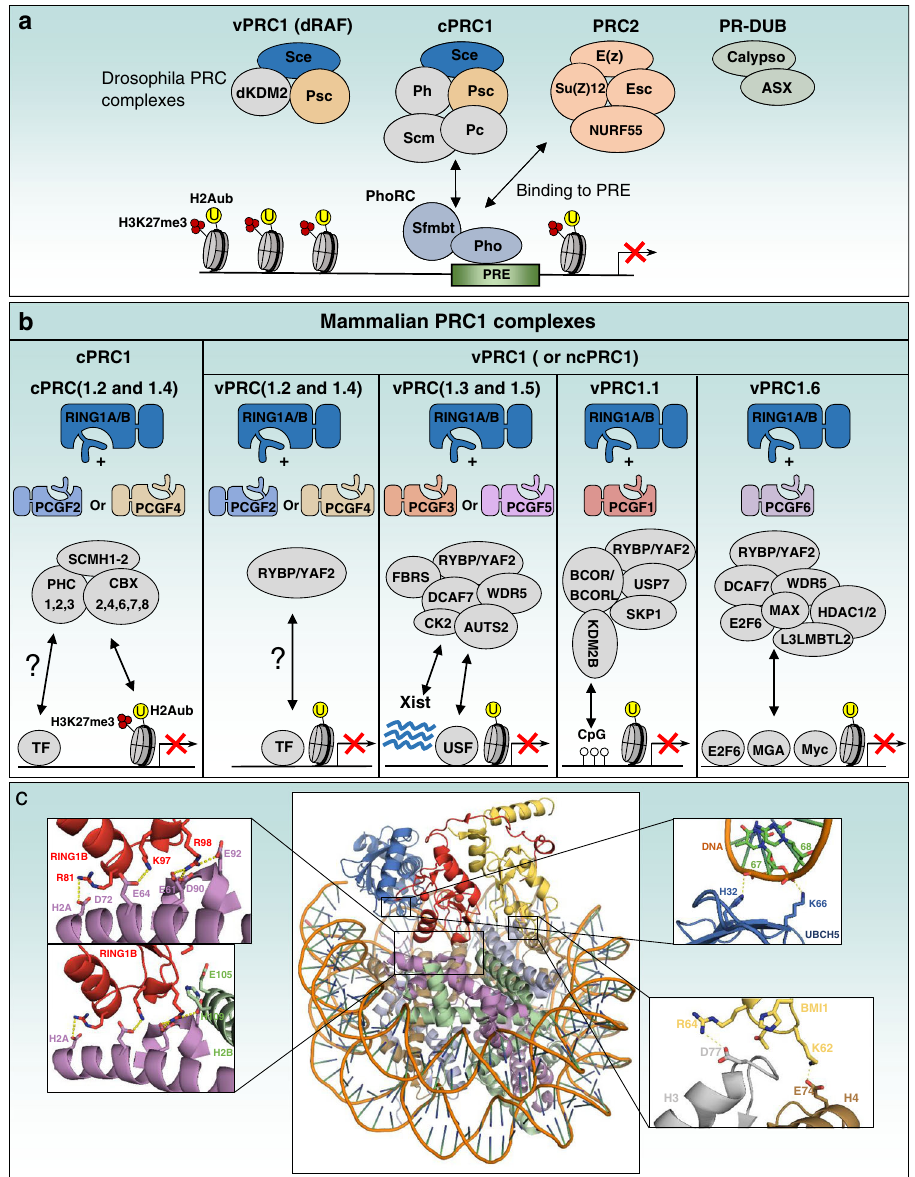
Fig. 2 PcG complexes in Drosophila and PRC1 complexes in mammals. a Schematic representation of the fi ve PcG complexes in Drosophila: canonical (cPRC1) and variant (vPRC1:dRAF) PRC1 complexes, PRC2 complex, PR-DUB complex and PhoRC complex. PhoRC binds to gene regulatory regions via the interaction of its subunit Pho with speci fi c DNA sequences, PRE (PcG Responsive Elements). Pho can also directly bind to components of cPRC1 complexes to mediate their recruitment even in the absence of H3K27me3. The arrows indicate protein interactions responsible for the recruitment of PcG complexes to the PRE. b Schematic representation of the canonical (cPRC1) and variant (vPRC1) PRC1 complexes in mammalians. RING1A or RING1B are obligate components of the PRC1 complexes. Their association with either PCGF2/PCGF4 or other PCGFs (PCGF1, PCGF3, PCGF5, PCGF6) lead to the formation of cPRC1 or variants vPRC1 complexes, respectively. CBXs/HPHs and RYBP/YAF2 associate in mutually exclusive manner with RING1A/RING1B for the formation of cPRC1 and vPRC1 complexes, respectively. H3K27me3 and CpG islands recruit cPRC1 and vPRC1/PCGF1 complexes respectively. Transcription factors (TF), USF and other chromatin factors (E2F6, MGA, MYC) might also be involved in the recruitment of PRC1 to chromatin. The arrows indicate protein-protein or protein DNA/RNA interactions responsible for the recruitment of PRC1 complexes to chromatin. Ubiquitination is shown as the yellow circle and H3K27me3 is shown by the three red circles ( a , b ). c In the center, crystal structure of a minimal human PRC1 complex (RING1B /BMI1-UbcH5c) interacting with the nucleosome core particle (NCP) (PDB: 4R8P). The left panels show the contact between RING1B and H2A/H2B acidic patch. The top right panel shows the DNA-UBCH5 interactions. BMI1 also makes polar contacts with Histone H3 and H4 as shown in the bottom right panel. Interaction of RING1B with BMI1 on one hand and histone H2A on the other hand is essential for establishing H2Aub on the speci fi c DNA sequences called PRE (or PcG Responsive Ele- recruit its subunits directly to DNA, in the absence of ments) 48,49 . PRE-mediated gene silencing was later found to nucleosomes 53,54 (Fig. 2a). In addition, Sfmbt subunit of PhoRC involve DNA-binding PcG proteins such as pleiohomeotic Pho can directly interact with PRC1 and promote its recruitment at and Pho-like, whose vertebrate orthologue is YY1 36,50 – 53 . For PRE 55 . This might explain the presence of H2Aub in chromatin instance, Pho can bind to components of the PRC1 complex and regions in the absence H3K27me3 26 . Thus, PhoRC is possibly the